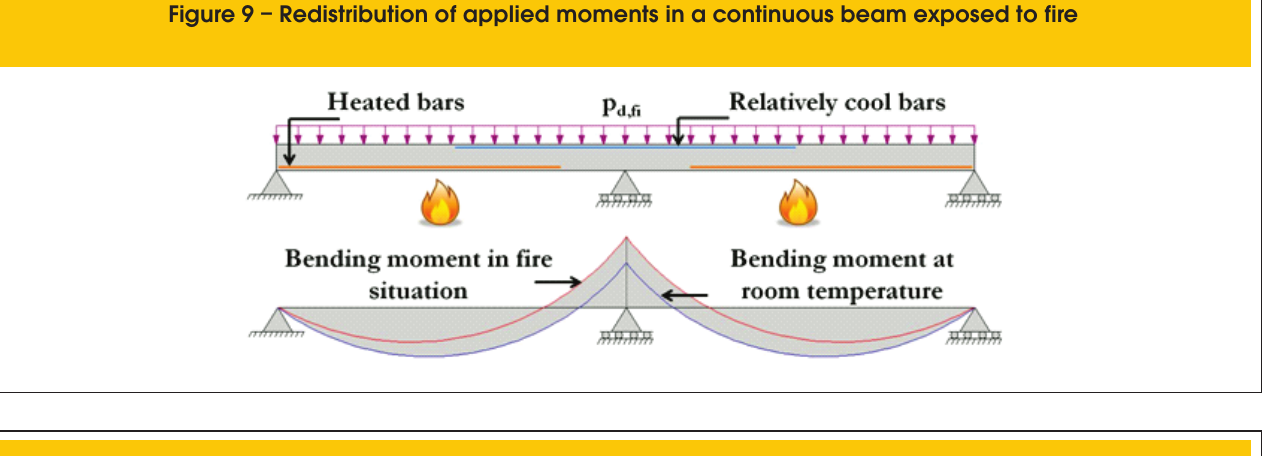
Figure 10 – Static sketch of beam and